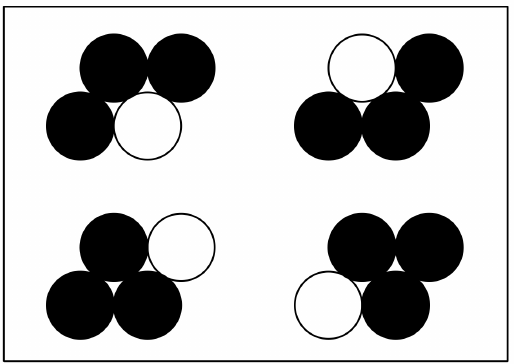
Figure 9. Positions for deposition of three Cu atoms (black) in a four atom fcc primitive cell. Only the bottom two structures have the single Pt atom (white) adjacent to a Cu 3,tri with three-fold hollow.